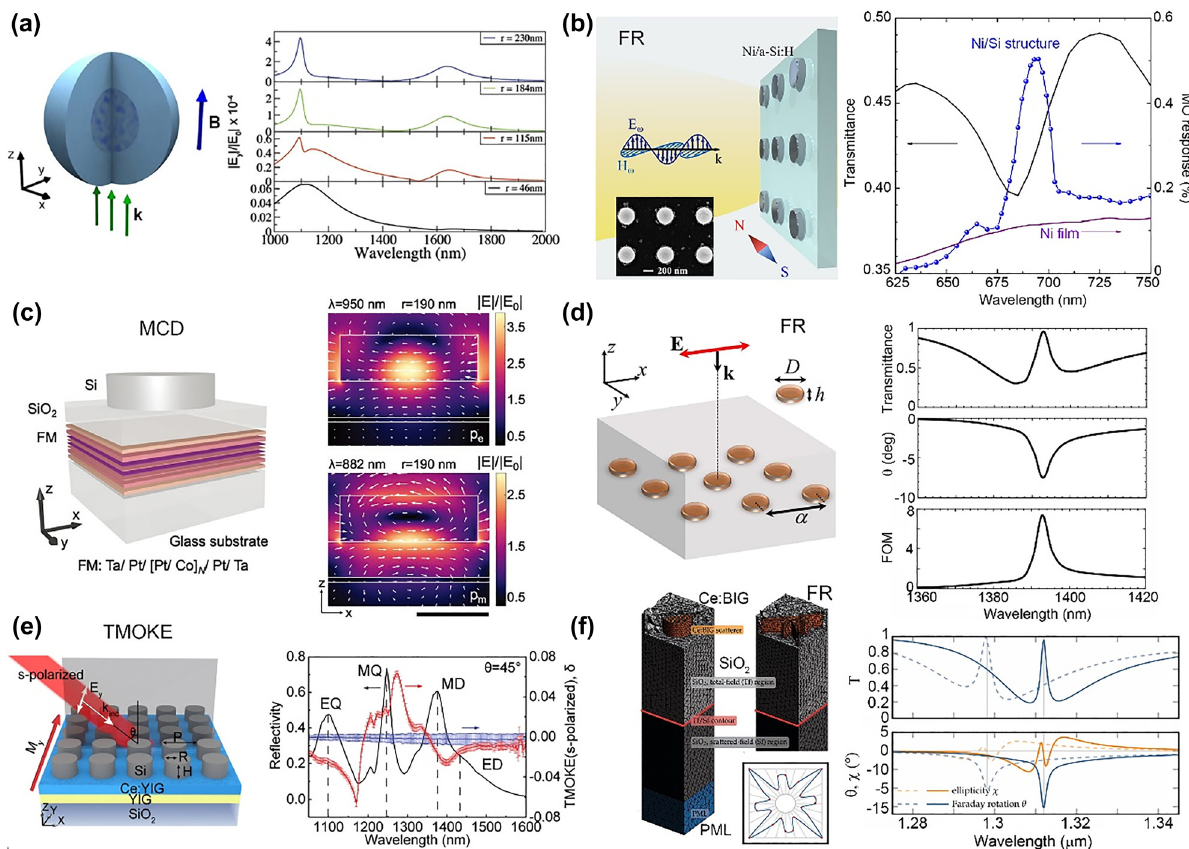
Figure 7: All-dielectric MO resonators with Mie resonances. (a) All-dielectric MO structure composed of Si spherical with a dielectric MO material core. The right figure presents the polarization rotation for different magnetic core radii: 230 nm, 184 nm, 115 nm and 46 nm. (b) All-dielectric MO structure based on the array of α -Si nanodisks covered by a 5 nm-thick nickel fi lm. The right fi gure presents the experimental transmission (black, solid) and MO response (blue, circles). (c) All-dielectric MO structure based on α -Si nanodisks on ferromagnetic metallic multilayers. The right fi gure presents the electric fi eld magnitude and direction maps of disk cross-sections at electric (top) and magnetic (bottom) resonances for disk radius of 190 nm. (d) All- dielectric MO structure with BIG periodic nanodisks, which supports the EIT modes. The right fi gure presents the transmission ( T ), FR ( θ ) and FOM ( √ T | θ | ) spectra when EIT is excited. (e) All-dielectric MO nanoresonators composed of Si nanodisks on Ce:YIG thin fi lms. S-polarized TMOKEis observed,whichisabsentinabareCe:YIG fi lm.The right fi gurepresentsthere fl ectivity(blackcurve),s-TMOKEspectrum(redcurve) of the metasurface, and the s-TMOKE spectrum of the bare Ce:YIG fi lm (blue curve). (f) All-dielectric MO structure based on Ce:BIG scatterers optimized by Bayesian algorithm. The right fi gure presents the spectra for transmittance, FR and ellipticity. The panels of this fi gure contain pictures adapted from References [65, 66, 114, 117 –